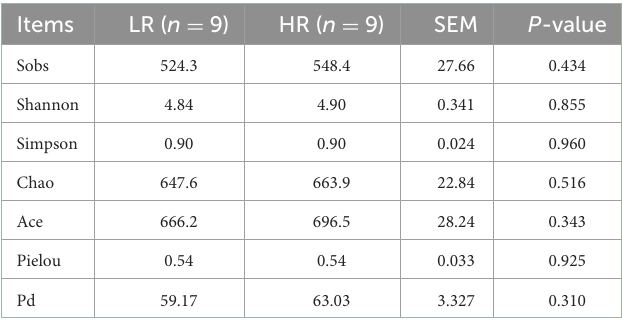
TABLE 3 Effects of RFI divergence on α -diversity of small-sized meat